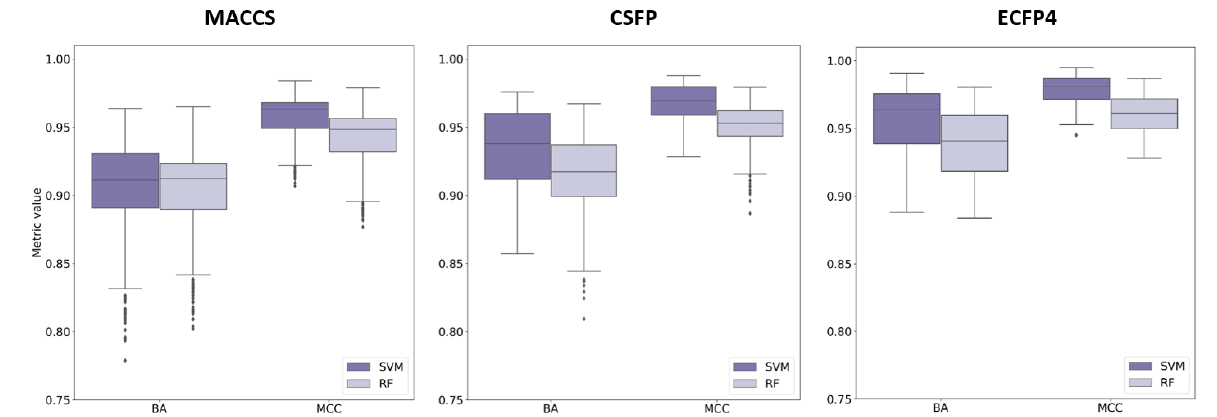
Figure 6. Compound classification. Boxplots report the performance of machine learning models (SVM: blue, RF: orange) using MACCS, CSFP, and ECFP4 in compound classification based on the BA and MCC measures.